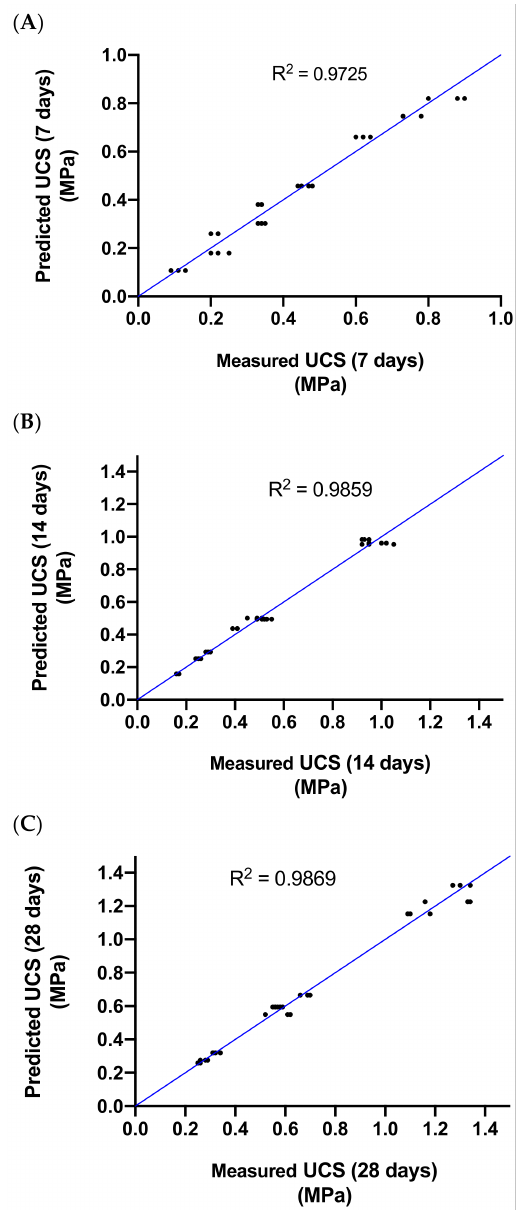
Figure 11. Predicted vs. measured UCS after curing backfill samples for ( A ) 7 days, ( B ) 14 days, and ( C ) 28 days. Table 8. ANOVA results for UCS regression models of backfill specimens cured for 7, 14, and 28